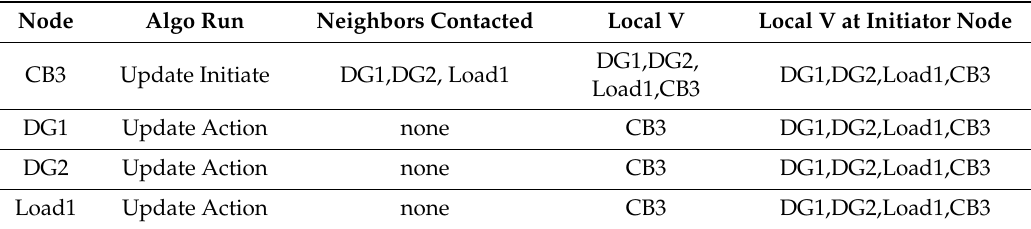
Table 3. Application of update algorithm on